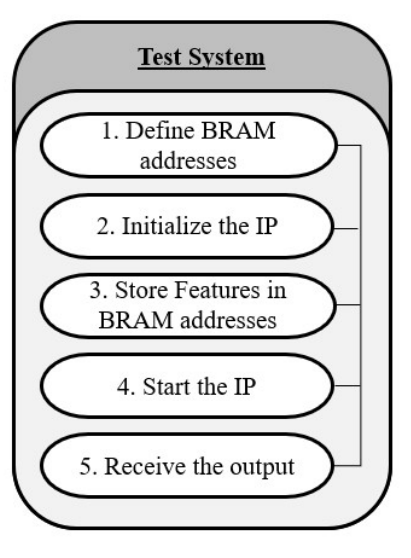
Figure 8. SDK test for the DM